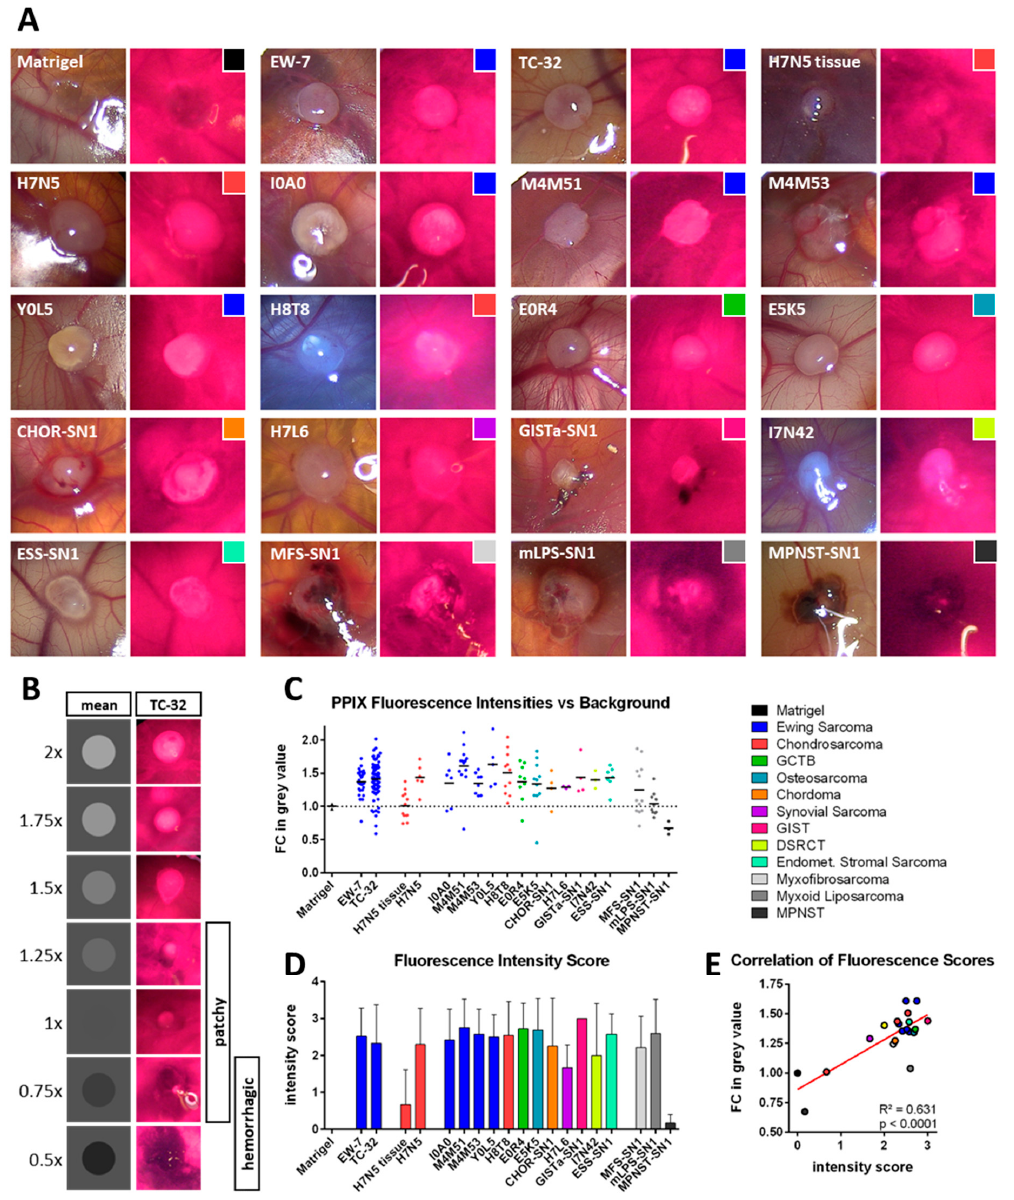
Figure 1. Photodynamic Diagnosis of Sarcoma xenografts on the chorio-allantoic membrane. ( A ) Overview of representative images of sarcoma xenografts upon white light (left images) and blue light (405 nm; right images) excitation. PPIX fluorescence presents as pinkish red. ( B ) For data visualization purposes, fold changes (FC) in mean grey values are depicted as grey circles on a grey background. TC-32 tumors with corresponding fluorescence intensities are shown adjacently. Tumors with an FC in mean grey value between 0.75 and 1.25 showed in most cases a patchy/partial fl uorescence, while values below 1 were associated with a hemorrhagic phenotype. ( C ) FCs in mean grey value between tumors and their surrounding CAM tissue were calculated for all tested xenografts and cell-free Matrigel ® as a control. ( D ) A fl uorescence intensity score was determined qualitatively for each tumor visually while performing PDD. Mean intensity scores with the respective standard deviation are depicted. ( E ) Correlation of mean values of both intensity scores from ( C , D ). The legend shows the color code for the different sarcoma subtypes and is shared by ( A , C – E